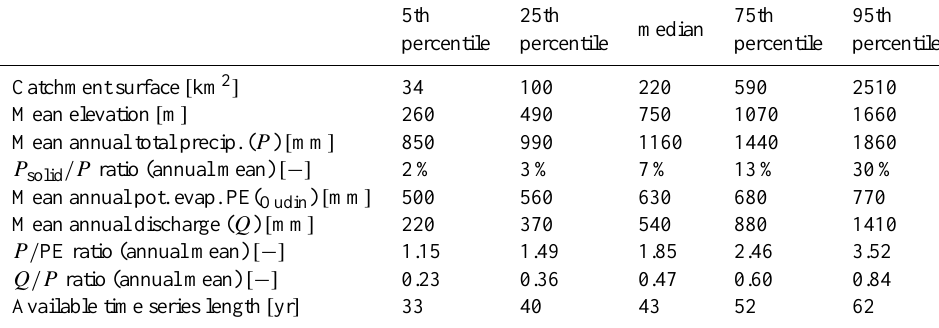
Table A1. Characteristics of the enlarged catchment set used in the additional testing (365 catchments).